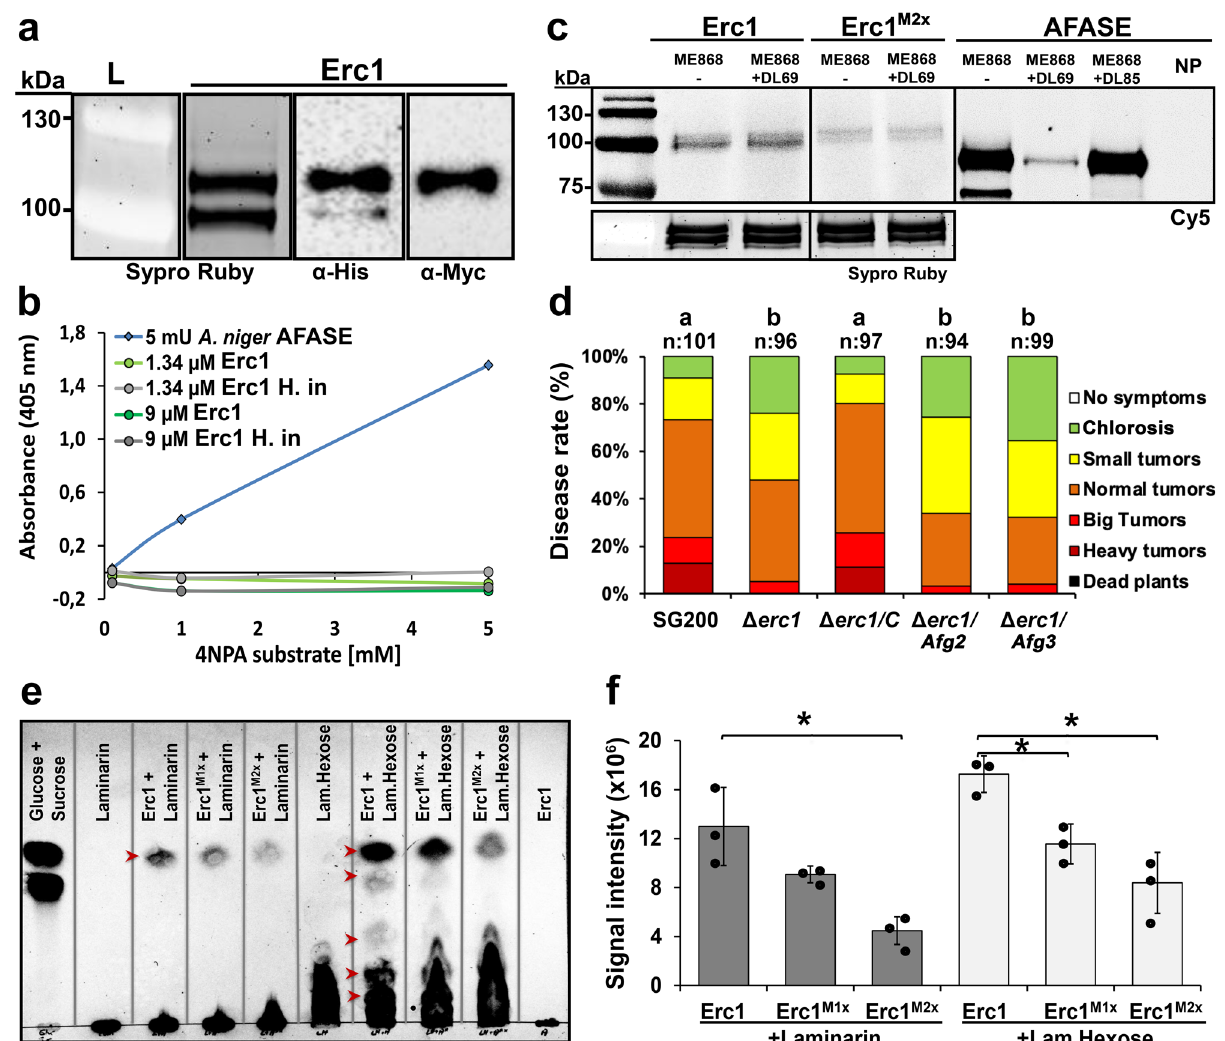
Fig.4|FunctionalcharacterizationoftheErc1protein.a Puri fi cationofHis-Erc1- Myc-His recombinant protein. Sypro Ruby staining was performed to visualize the Erc1 recombinant protein. Western blot (WB) analysis was performed with α -His- and α -Myc- speci fi c antibody to detect His-Erc1-Myc-His protein. While two bands were detectable in Sypro Ruby staining and WB performed with α -His, only one bandwasdetectablewith α -Myc-speci fi cantibody.Similarresultswereobservedat least in two independent biological replicates. b α -L-arabinofuranosidase activity assaywith 4-nitrophenyl α -L-arabinofuranoside(4NPA) substrate.A commercial α - L-arabinofuranosidase from Aspergillus niger (AFASE) was used as a positive con- trol. Data are presented as mean value of three independent biological experi- ments. c Activity-basedproteinpro fi ling(ABPP)assayforErc1.TheErc1,Erc1 M2x and AFASE recombinant proteins were incubated with the speci fi c α -L- arabinofuranosidase inhibitor DL69. Plus (+) and minus ( − ) indicate the addition and the absence of the inhibitor, respectively. α -L-arabinofuranosidase speci fi c probeME868wasaddedasindicated(+/-).Theprobewasdetectedbyscanningthe in-gel fl uorescence with Cy5 fi lter (Ex. 650nm, Em. 670nm). Protein of loaded samples were visualized via Sypro Ruby (Ex. 450nm, Em. 610nm). NP: no probe control. Similar results were observed in two independent biological experiments. d Complementation of SG200 Δ erc1 mutant with Afg2 and Afg3 under the native